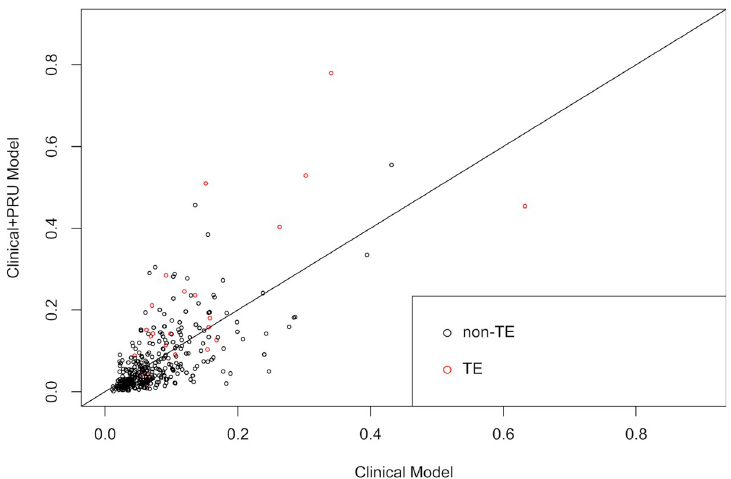
Fig 3. Comparison between the clinical model and clinical+ PRU model using the net reclassification index and integrated discrimination index. Scatter plot showing the predicted probability of infarction as shown by the Clinical model and Clinical+ PRU model. The red and black circles indicate patients with and without TE, respectively. Abbreviations: TE, thromboembolic event; PRU, P2Y 12 reaction